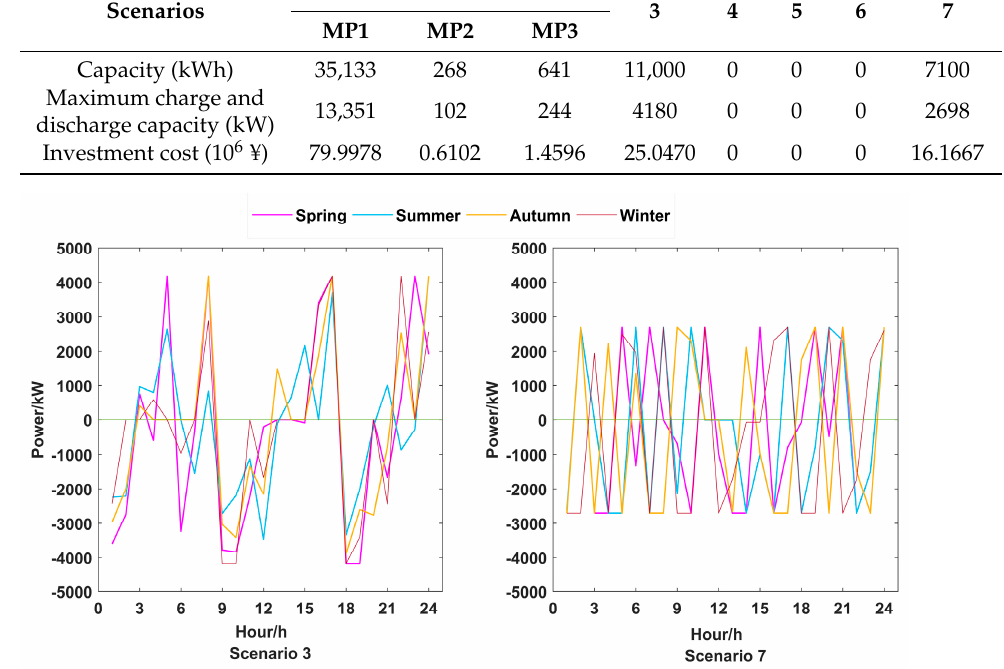
Figure 9. SESPS charge and discharge in scenarios 3 and 7.